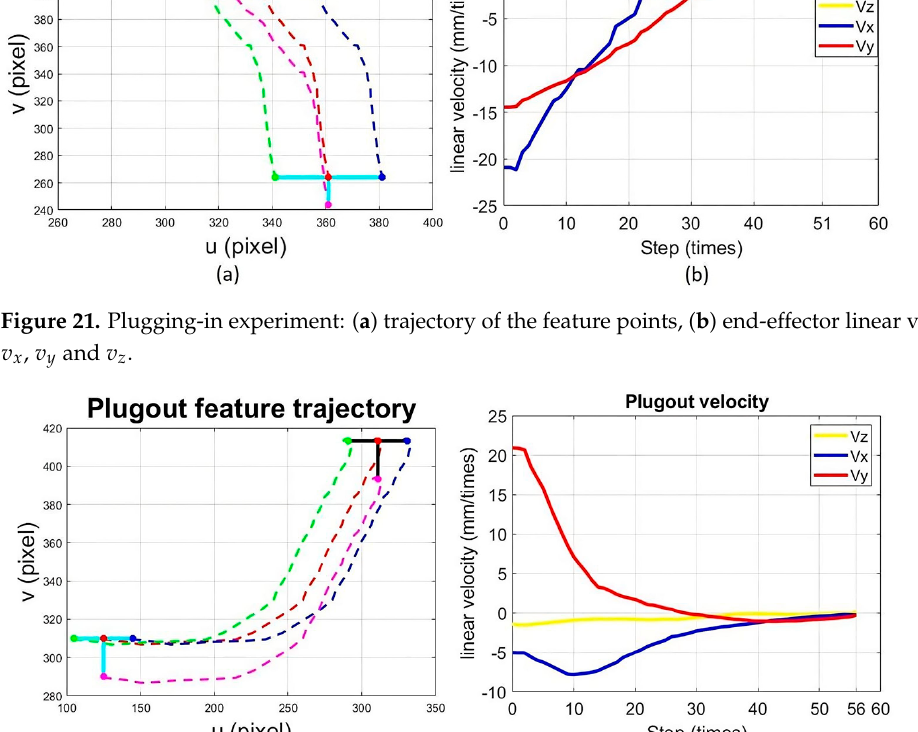
Figure 21. Plugging-in experiment: ( a ) trajectory of the feature points, ( b ) end-effector linear velocity 𝑣 , 𝑣 and 𝑣 . (cid:3051) (cid:3052) (cid:3053) Figure 22. Unplugging experiment: ( a ) trajectory of the feature points, ( b ) end-effector linear velocity v x , v y and v z . Table 5. Plugging/unplugging experimental results for each test.